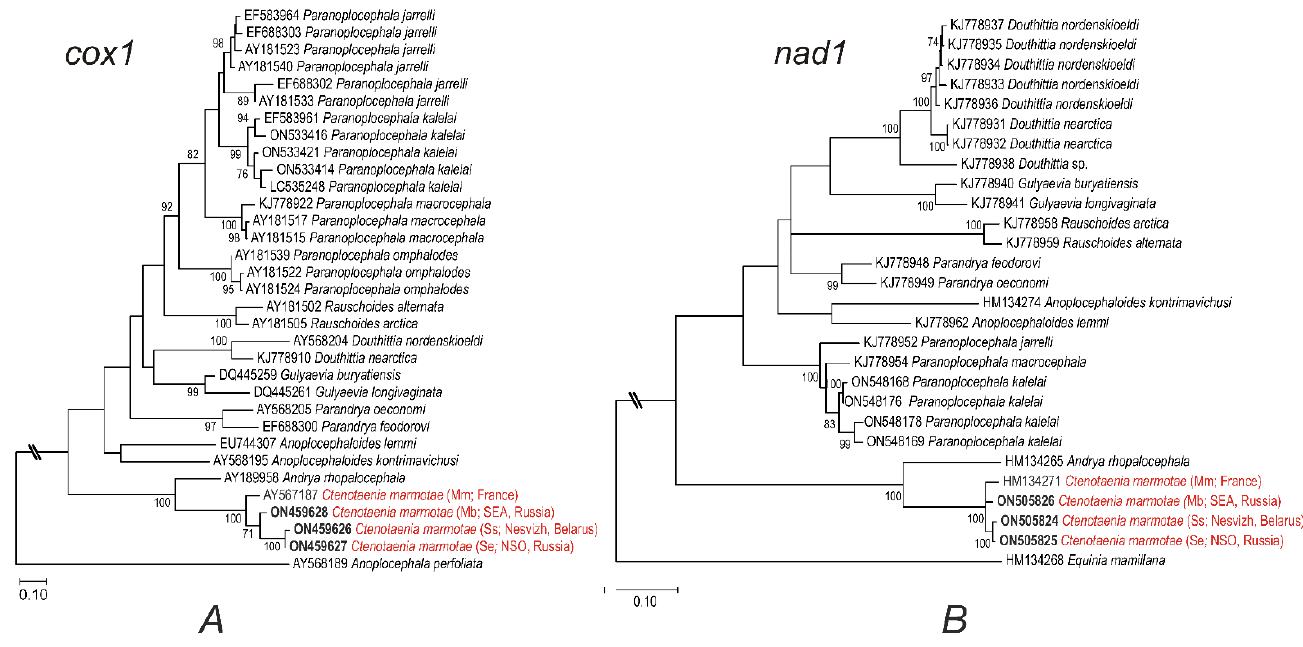
Figure 2. Phylogenetic relationships of Ctenotaenia marmotae (shown in red). The analysis was performed by the maximum likelihood method. ( A ): cox1 gene tree; ( B ): nad1 gene tree. Each tree is given to scale, with branch lengths measured in number of substitutions per site. The bootstrap support value is set in the nodes of the trees; values below 75 are not shown; the number of bootstrap replications is 1000. All positions containing missing data were eliminated (complete deletion option). GenBank access numbers in bold are those obtained by the authors. Mb— Marmota baibacina ;